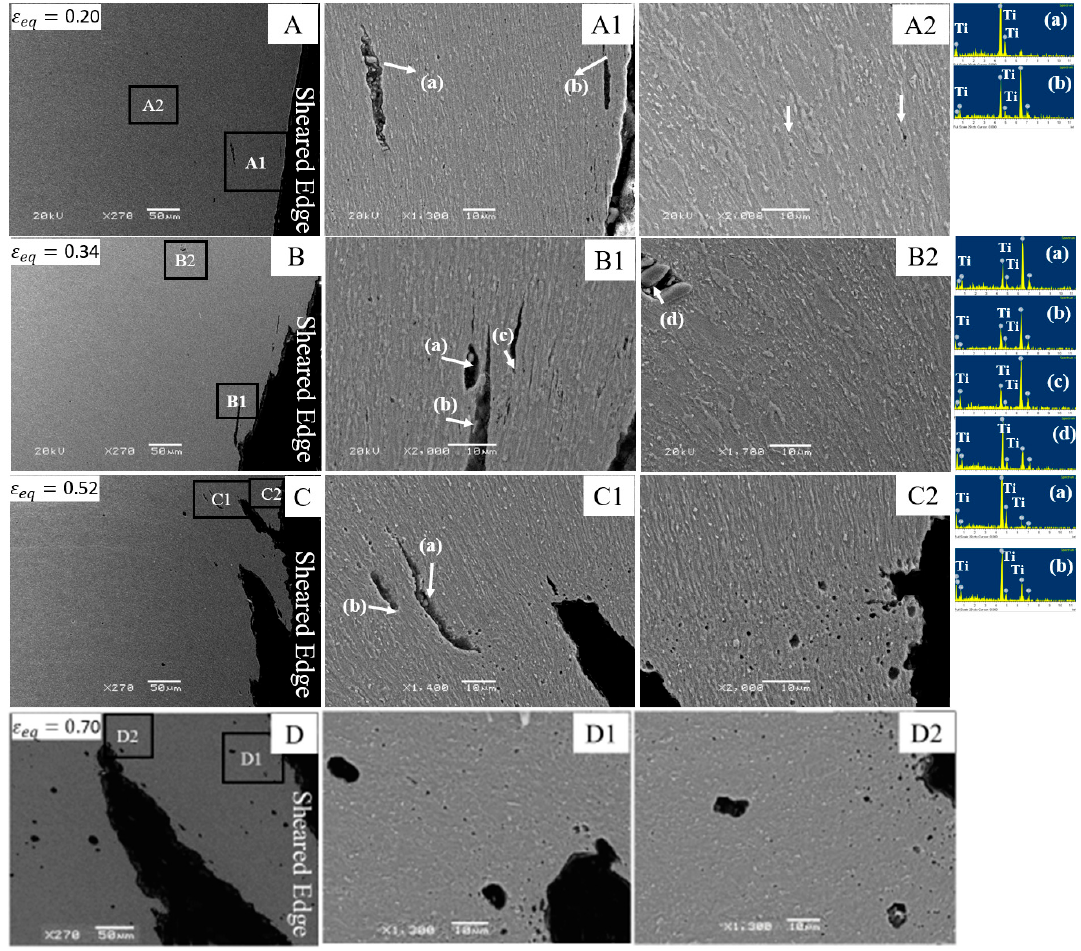
Figure 14. SEM micrographs of the interrupted CP800 reamed edge hole tension specimens at different strain levels: ( A ) 0.20; ( B ) 0.34; ( C ) 0.52; and ( D ) 0.70. strain levels: ( A ) 0.20; ( B ) 0.34; ( C ) 0.52; and ( D )